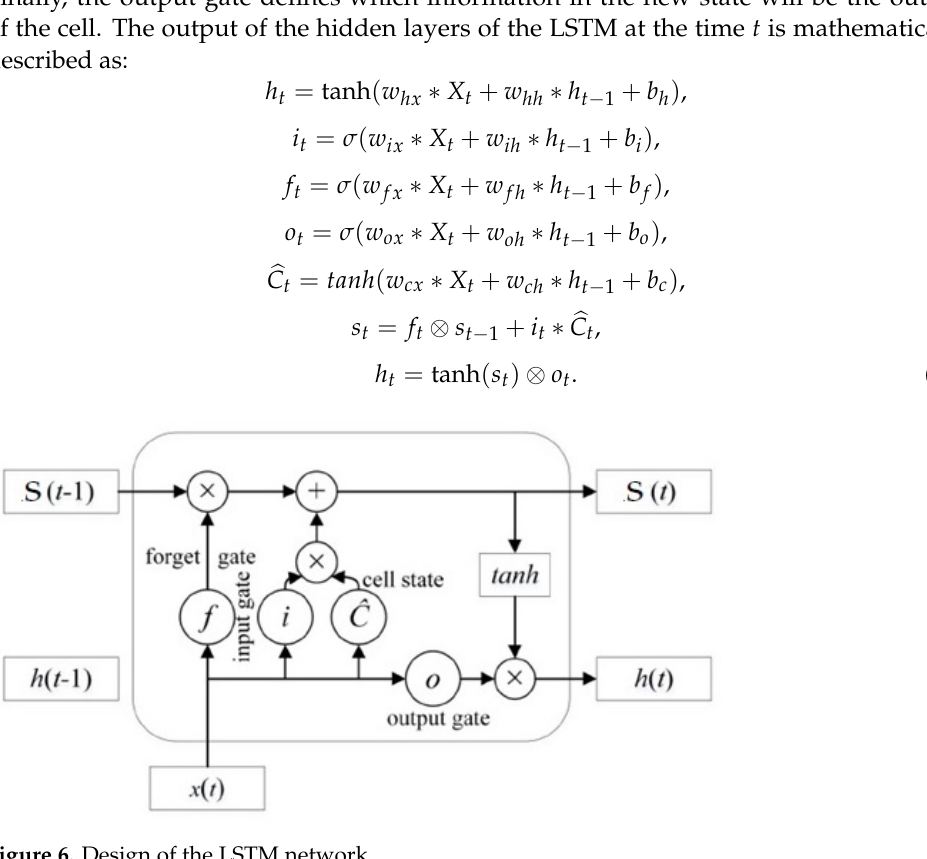
Figure 6. Design of the LSTM network.